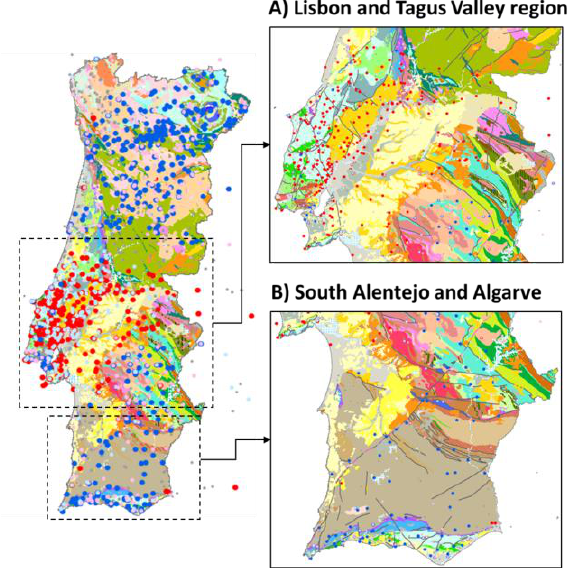
Figure 7. Cluster analysis of Anselin local Moran’s I with representation of geological structures (Geological map of Portugal, LNEG)